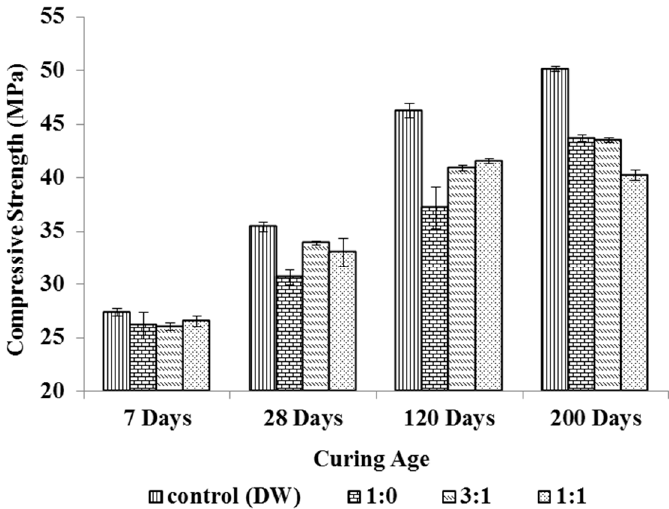
Figure 8. The effect of dilution ratio of PTW ((PTW: DW); 1:0, 3:1, 1:1) on the development of concrete compressive strength at curing age 7, 28, 120, and 200 days.